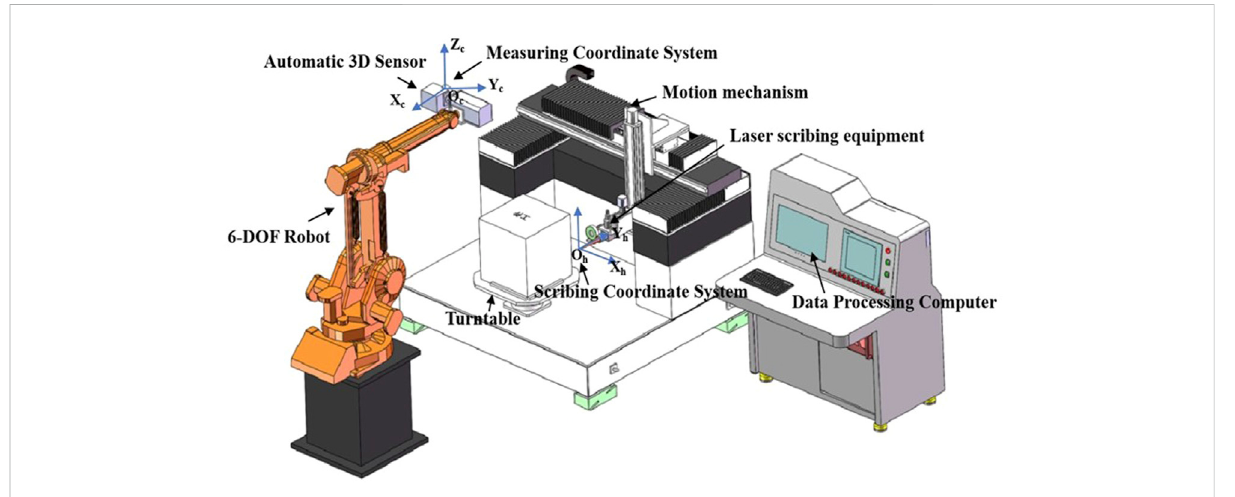
FIGURE 1 The 3D measurement and scribing